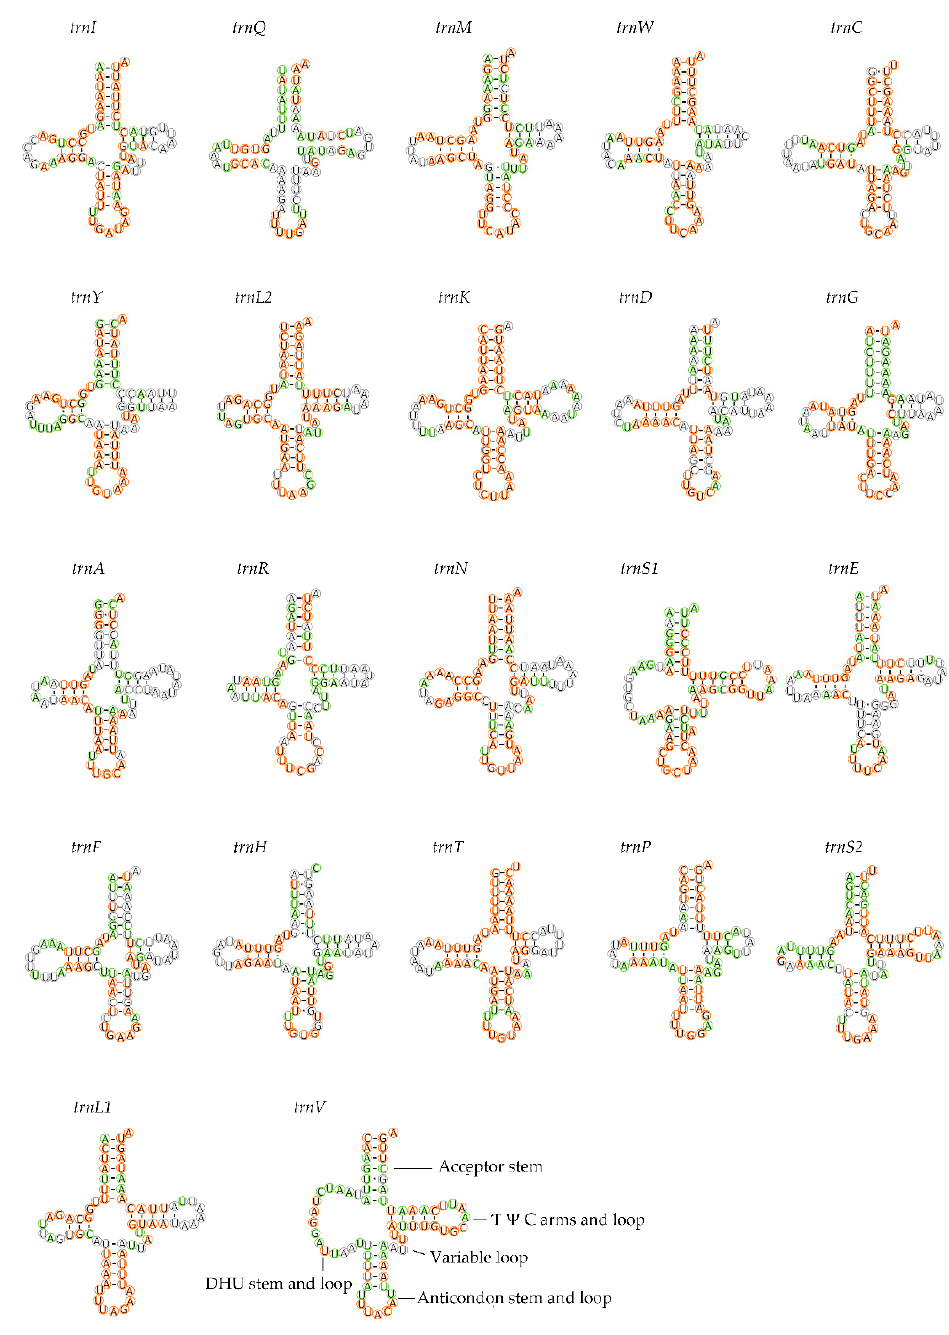
Figure 4. Potential secondary structure of tRNA in Eysarcoris rosaceus . The sites conserved within Eysarcoris are labeled in green, and those of Pentatominae are marked in orange.